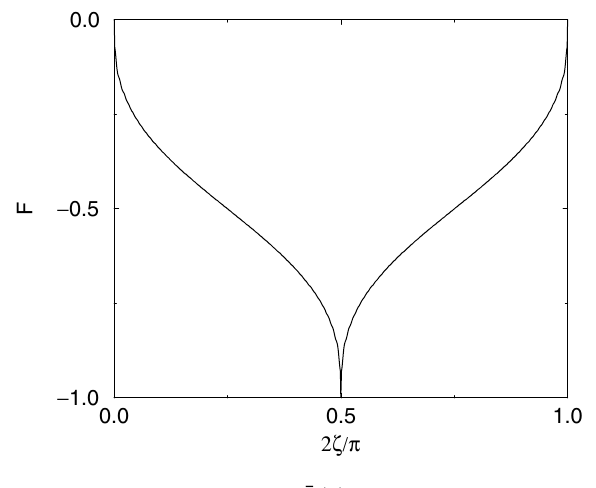
FIG. 4. The imaginary part of the normalized impedance Z (cid:5) k (cid:6) =k as a function of the normalized wave number k=k w Solid line: numerical solution from Eq. (23); dotted line: analytical low-frequency asymptotic behavior from Eq. (26); and dashed line: analytical high-frequency asymptotic behav- ior from Eq. (27).